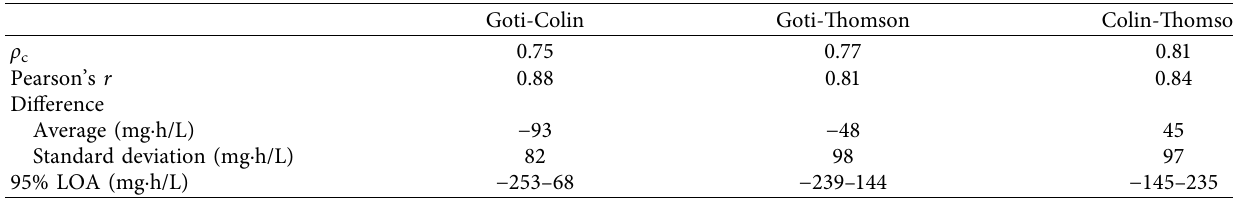
Table 3: Concordance between